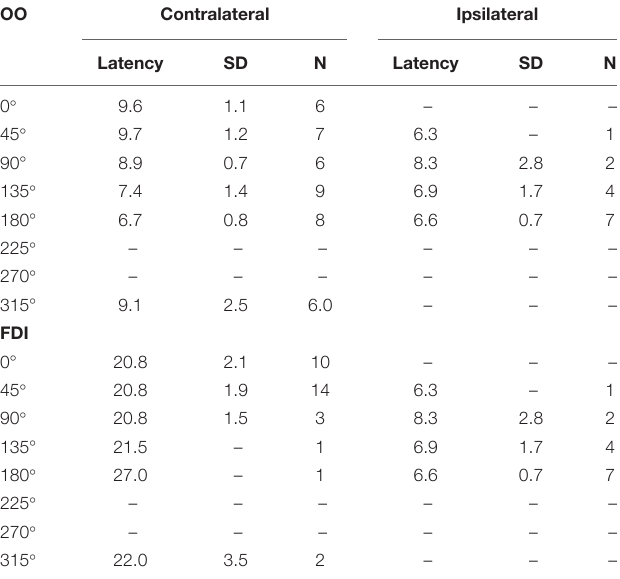
TABLE 2 | Average response latency duration in milliseconds, plus standard deviations (SD), and number of subjects (N) contributing to the average, for Orbicularis Oris (OO) and First Dorsal Interosseus (FDI) muscles.